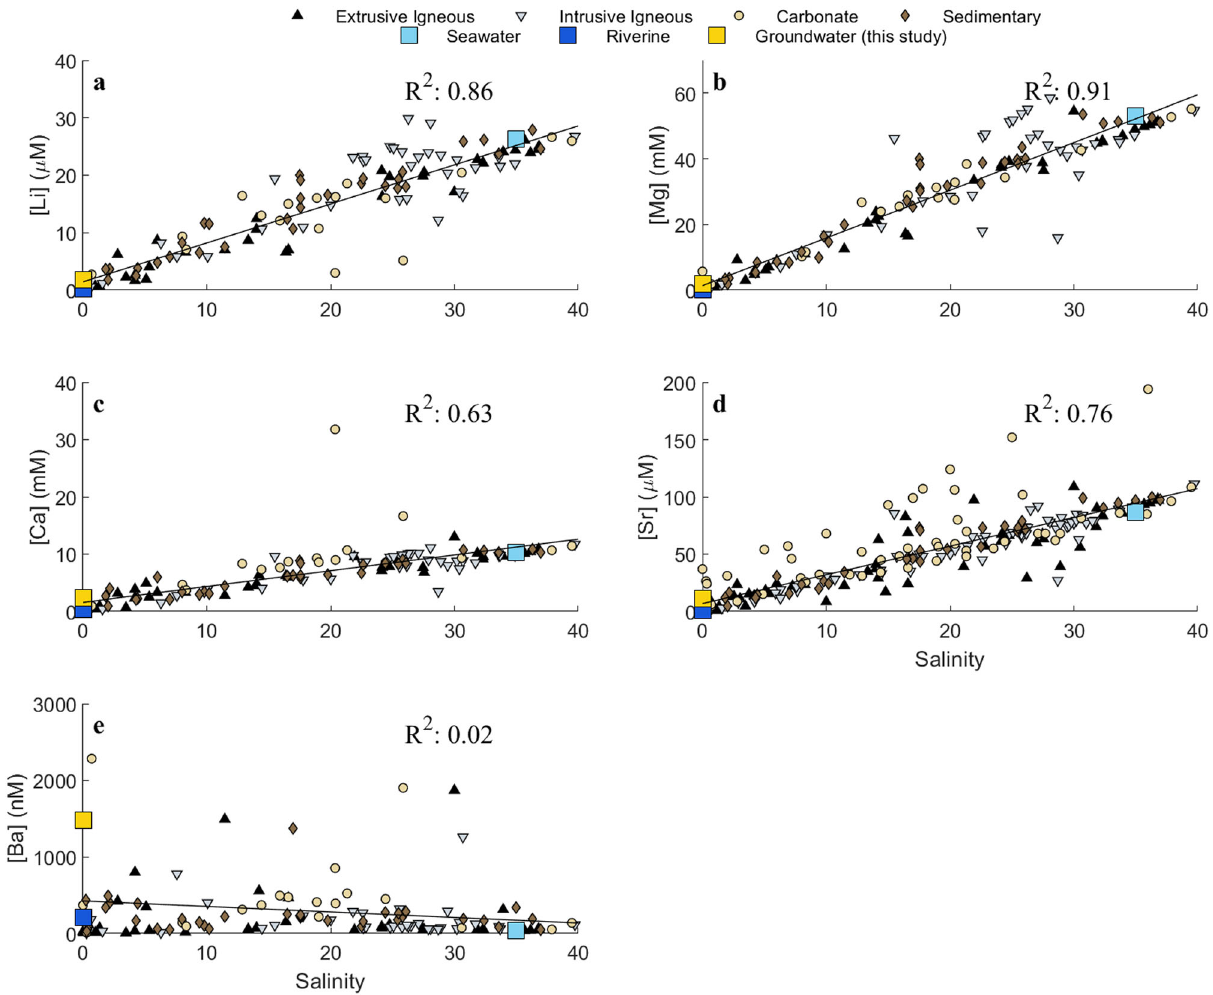
Fig. 2 Elemental concentrations in samples. a – e Cation concentrations with respect to salinity, organized by lithologic aquifer type, plotted alongside relevant endmember values: seawater and global average riverine endmembers (references available in Table 1), as well as the average global groundwater composition calculated in this study. Linear regressions across all the data are plotted for each element to provide context of what conservative (Li, Mg, Ca, and Sr) vs. non-conservative (Ba) mixing across the salinity gradients would appear as. Sample sizes ( n ) are provided here: a [Li]: ( n = 136), b [Mg]: ( n